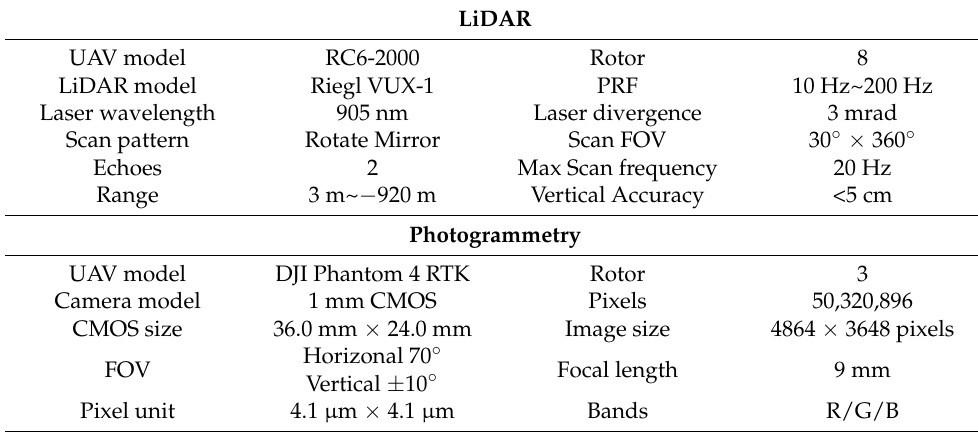
Table 2. The ULS and USP system